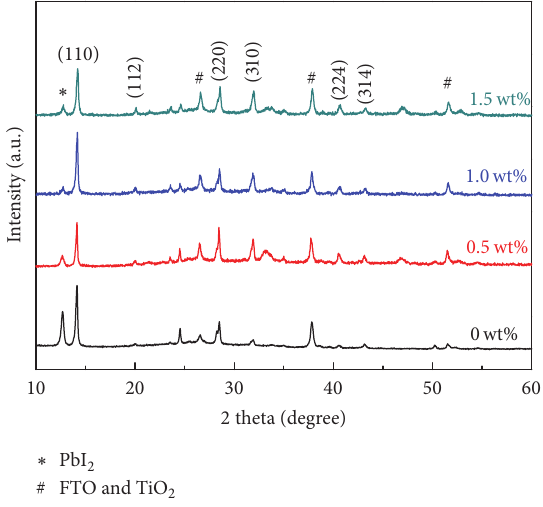
Figure 5: X-ray diffraction patterns of CH 3 NH 3 PbI 3 films based on TiO 2 mesoporous layers with different mass fractions of PS